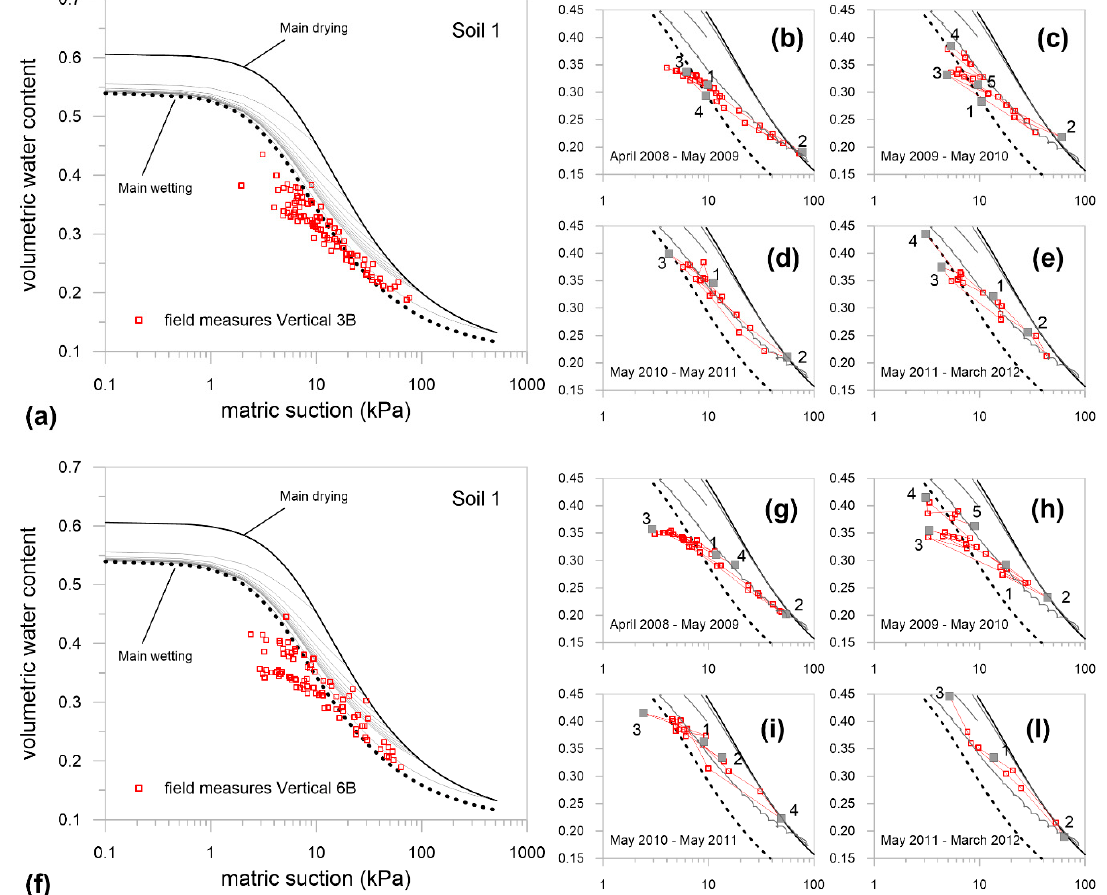
Figure 12. Pairs of matric suction and water content measurements collected at the site in soil 1 along verticals ( a ) 3B and ( f ) 6B compared to the main loop (continuous and dotted black lines) and to the secondary wetting paths starting from different points on the main drying curve (gray dotted lines). Field paths grouped by year and detected at vertical 3B ( b – e ) and at vertical 6B ( g – l ) compared to experimental path measured in the lab (test A).